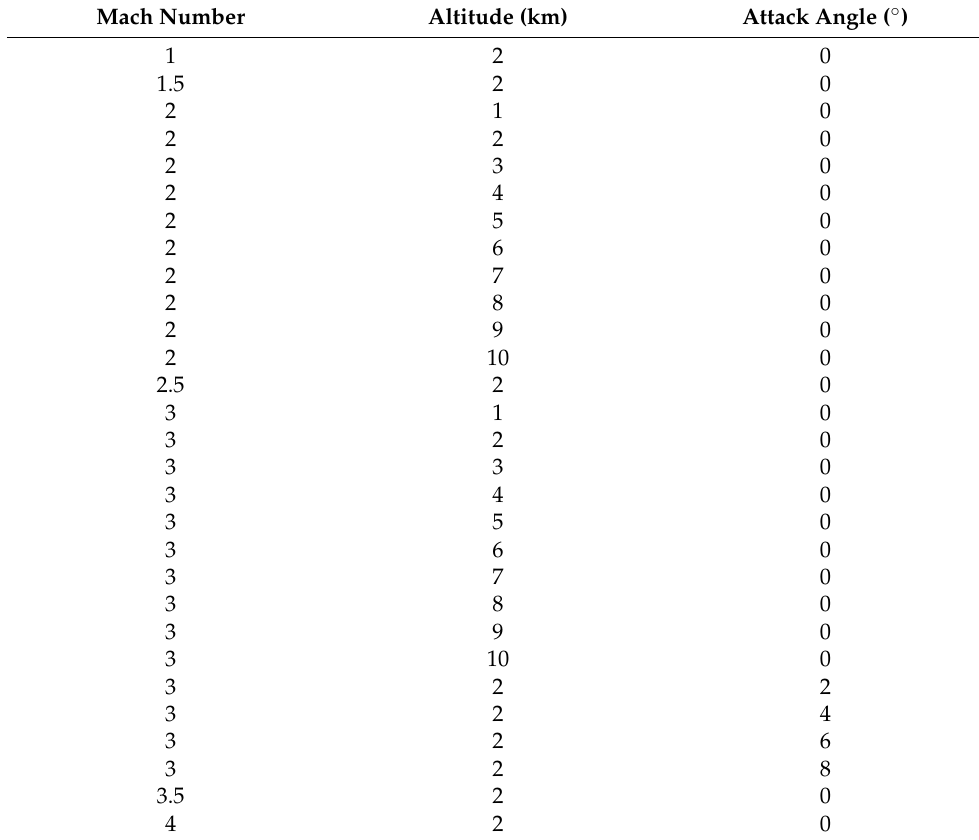
Table A1. The specific parameter